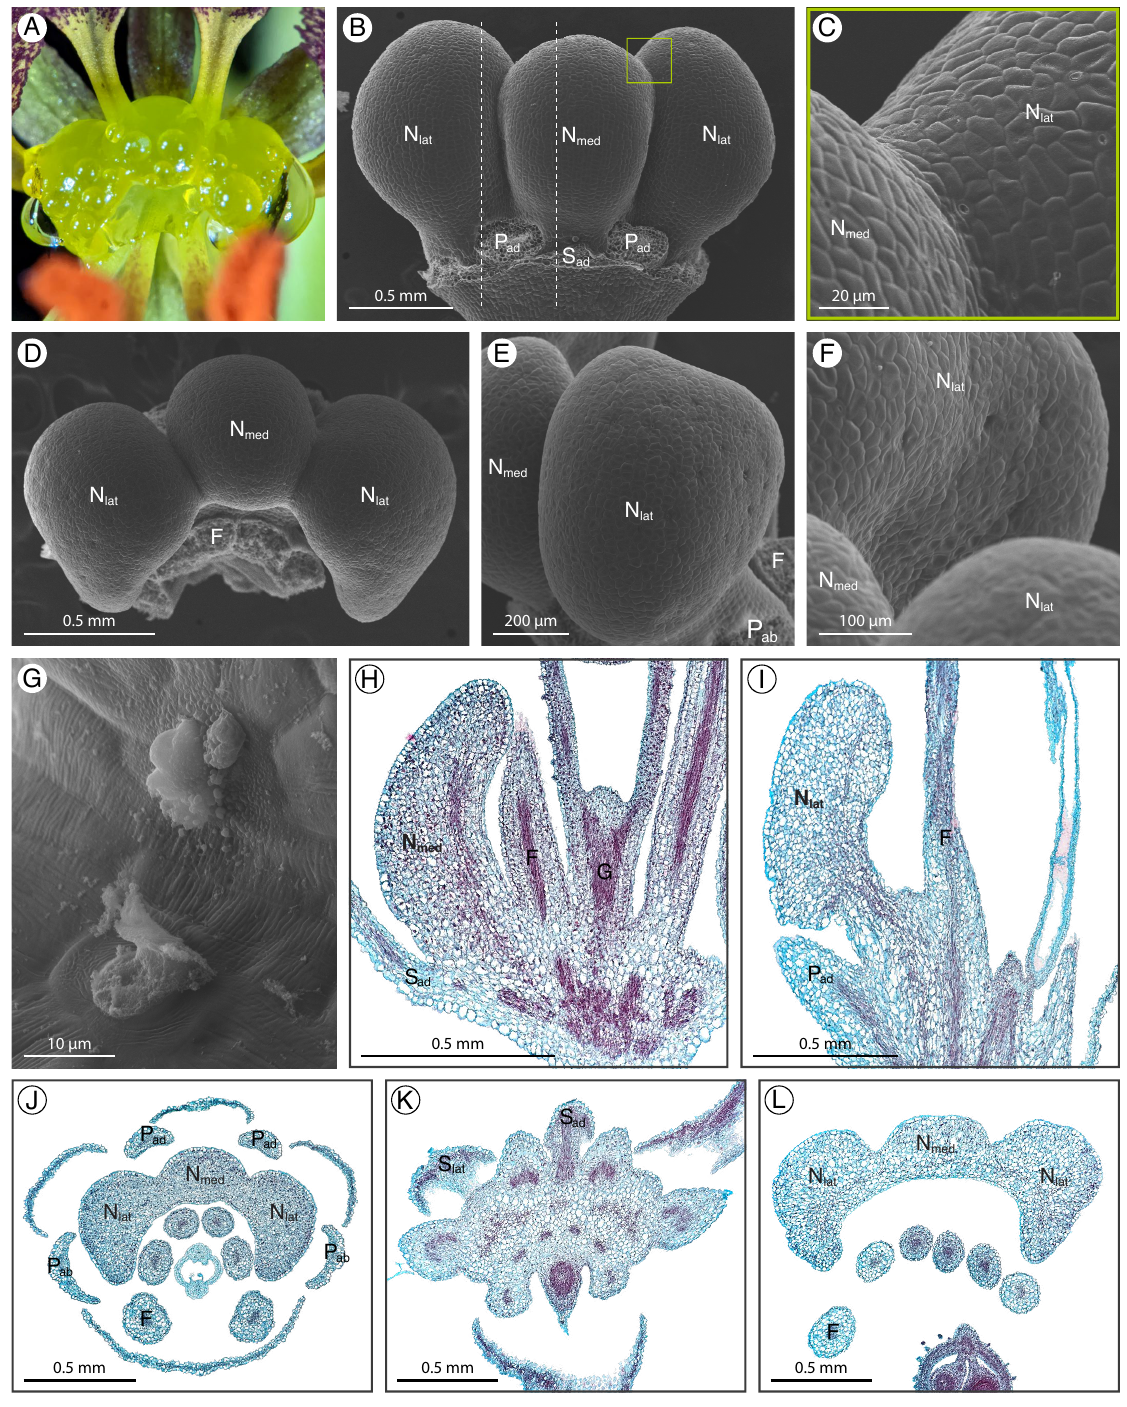
Figure 4. Cleome violacea nectary ( A ) photograph, ( B – G ) scanning electron micrographs, and ( H – L ) fast green and safranin O-stained sections. ( A ) Apical view of the nectary. ( B ) Adaxial view of the nectary. ( C ) Adaxial view close-up of the medial and lateral nectary lobes, corresponding to the box in ( B ). ( D ) Apical view of the nectary. ( E ) Lateral view of the nectary. ( F ) Lateral view close-up of the nectary. ( G ) Close-up of nectarostomata. ( H , I ) Longitudinal sections (sagittal plane) of the nectary, corresponding to the right and left dashed lines in ( B ), respectively: ( H ) intermediate stage nectary, and ( I ) anthetic stage nectary. ( J – L ) Transverse sections: ( J ) intermediate stage nectary, ( K , L ) anthetic stage nectary from proximal to distal positioning. All images are of anthetic stage specimens unless indicated otherwise. F: filament; G: gynophore; N lat : lateral nectary lobe; N med : medial nectary lobe; P ab : abaxial petal; P ad : adaxial petal; S ad : adaxial sepal; S lat : lateral